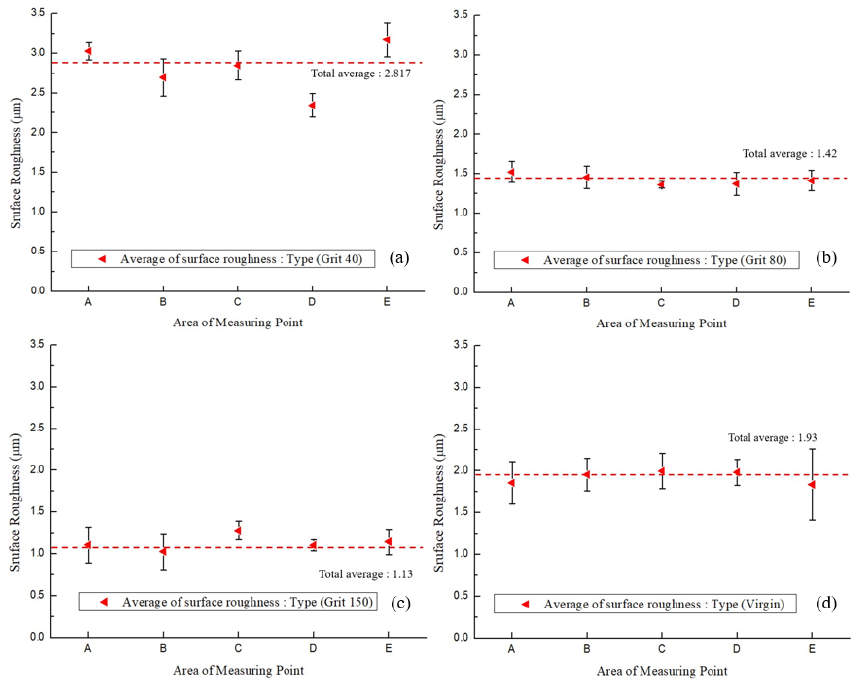
Figure 10. Result of average surface roughness of each condition. (a) Grit 40, (b) grit 80, (c) grit 150 and (d) virgin.